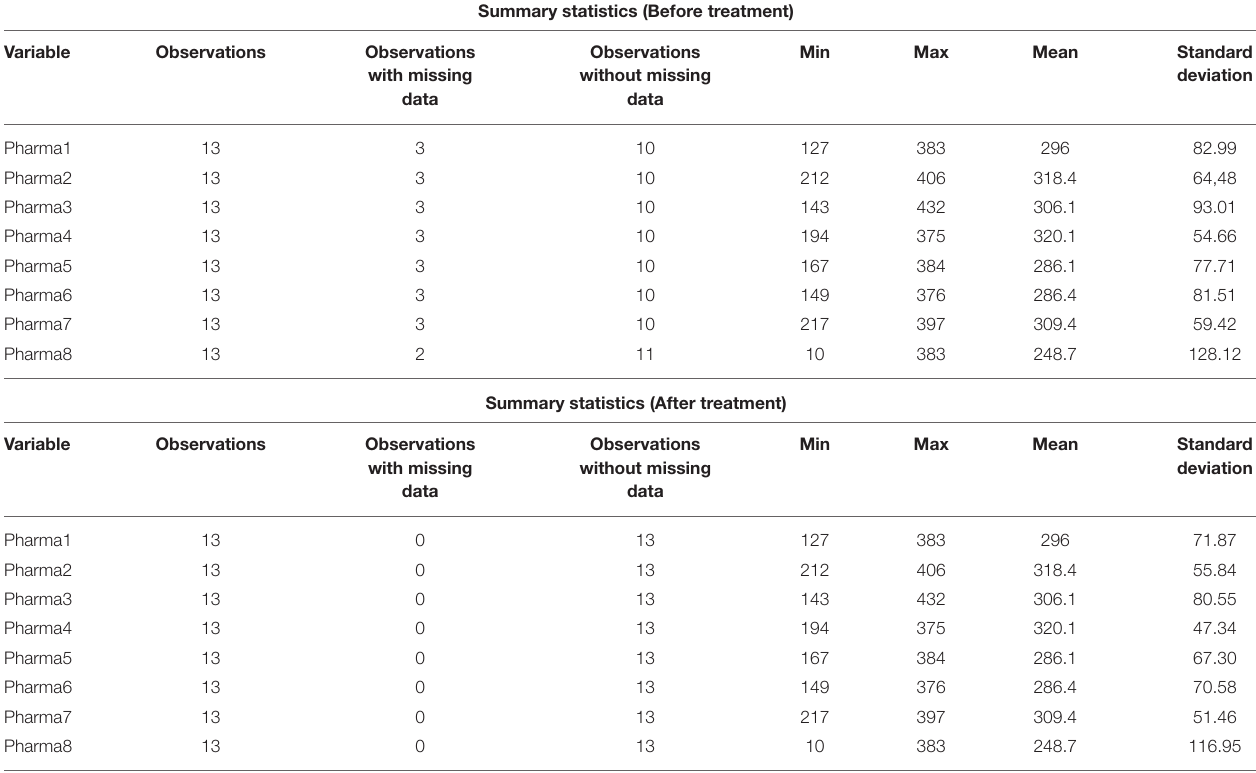
TABLE 9 | Summary statistics before treatment and after treatment (product with shortage). Summary statistics (Before treatment)